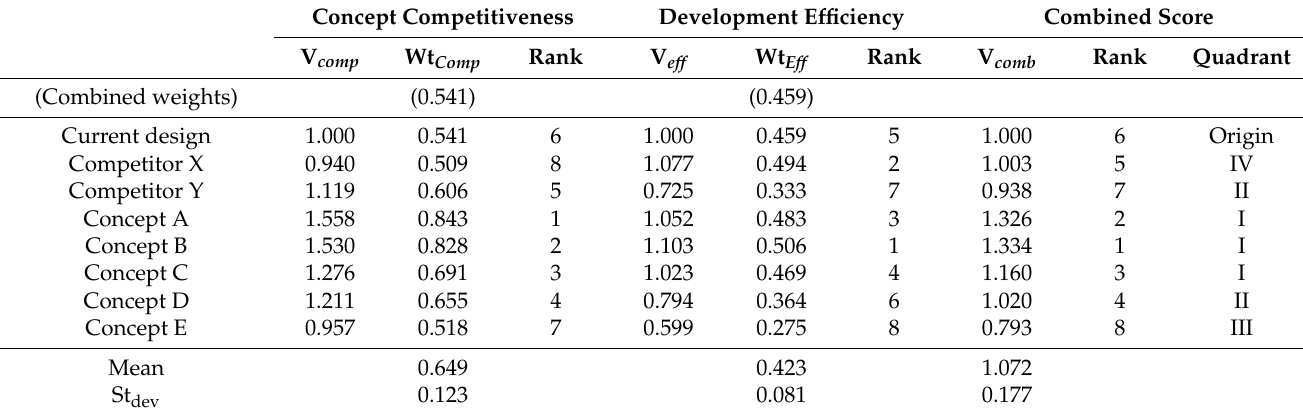
Table 6. Combined scores and quadrant analysis